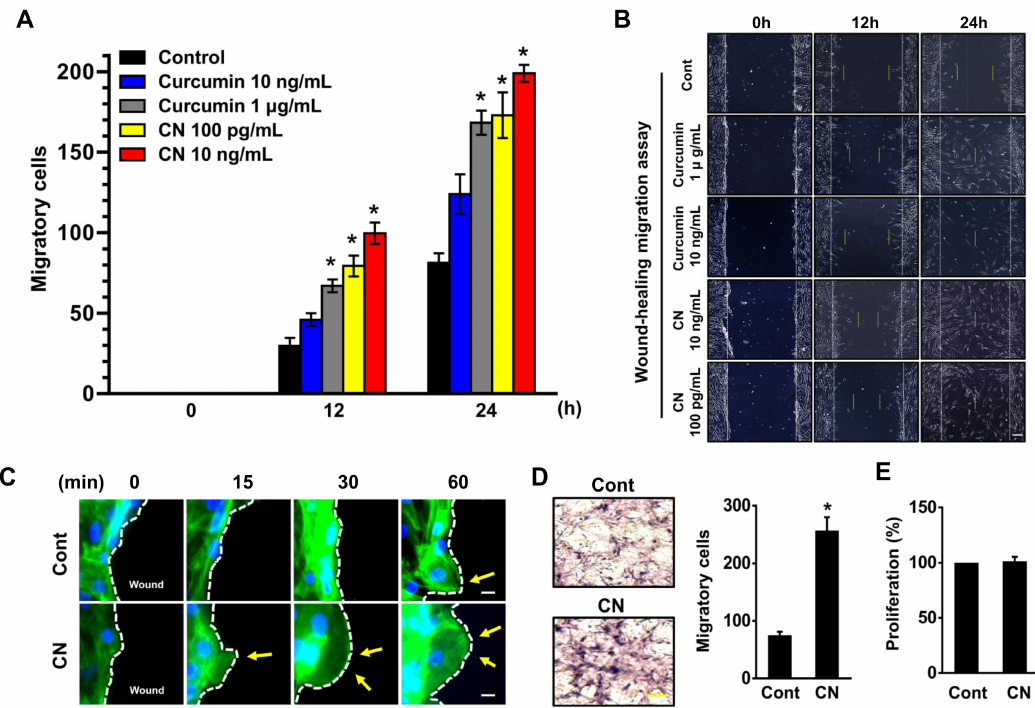
Figure 2. The e ff ect of CN on migration of human UCB-MSCs. ( A , B ) Dose and time responses of Curcumin (10 ng / mL and 1 µ g / mL) and CN (100 pg / mL and 10 ng / mL) in the migration of UCB-MSCs were quantified and visualized with the confocal microscopy. Scale bar represents 100 µ m (magnification, × 100). * p ≤ 0.01 versus control. ( C ) Lamellipodial extrusions in cells treated with CN of 100 pg / mL for 60 min are shown. Cells were fixed and labeled with phalloidin-Alexa Fluor 488 (green) to identify the leading edge of lamellipodia (arrows). Dashed lines indicate the leading edges. n = 3. Scale bars represent 100 µ m (magnification, × 400). ( D ) The migration capacity of UCB-MSCs treated with CN for 24 h was assessed in transwell permeable support with 8.0 µ m pore size membrane coated with Matrigel. Data represent the means ± S.E. n = 3. Scale bars represent 100 µ m (magnification, × 200). * p ≤ 0.001 versus control. ( E ) The proliferation of UCB-MSCs treated with CN for 24 h was determined by EZ-CYTOX cell proliferation kit. Data represent the means ± S.E. n =